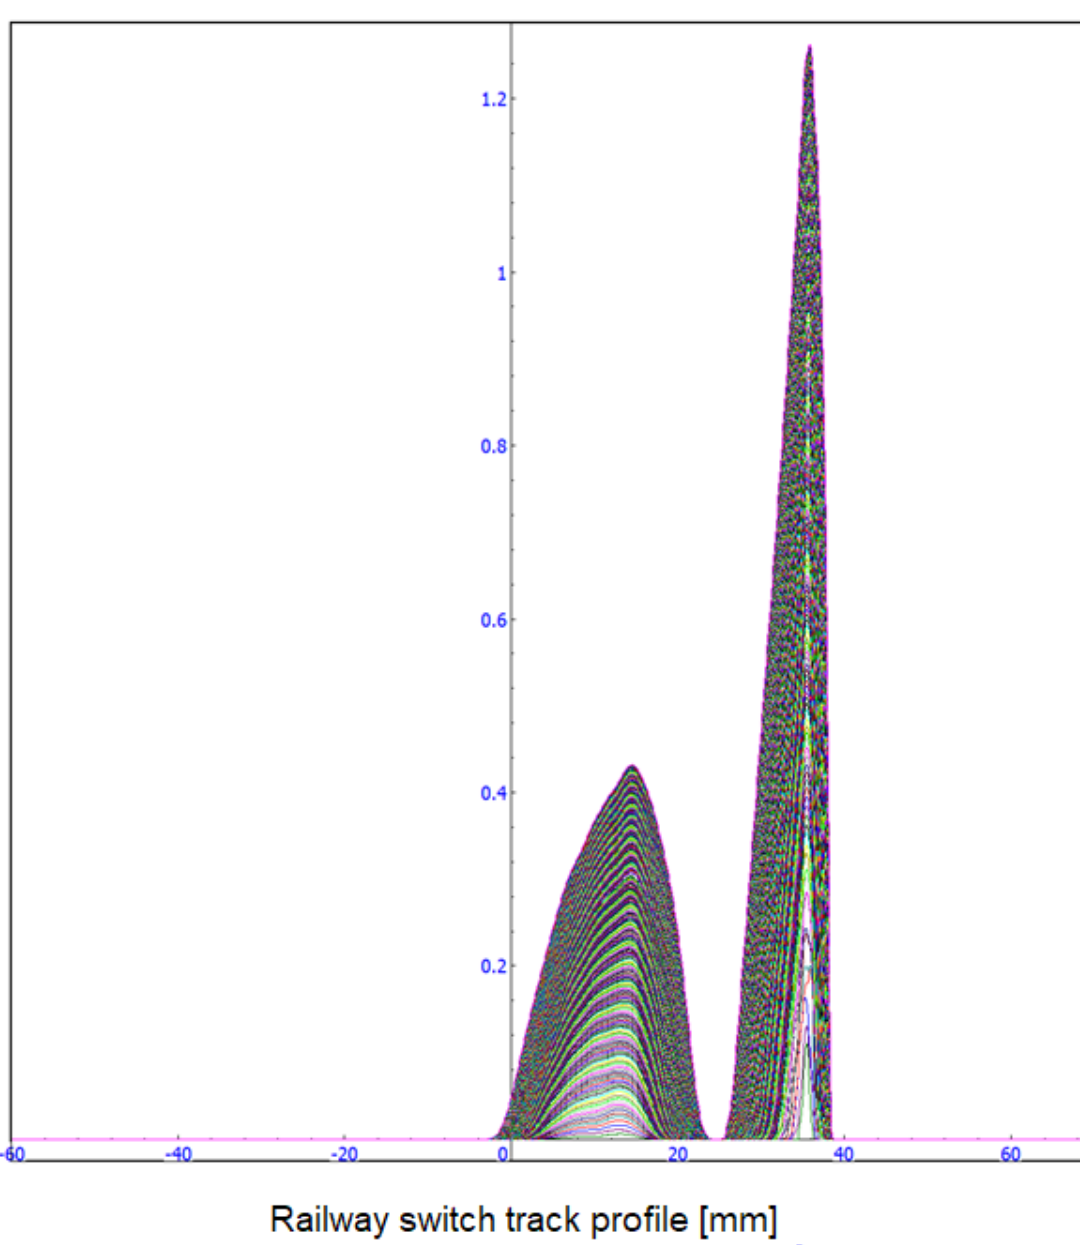
Figure 45. Rail wear for a railroad turnout at 350 km/h for straight-track traffic through the turnout.